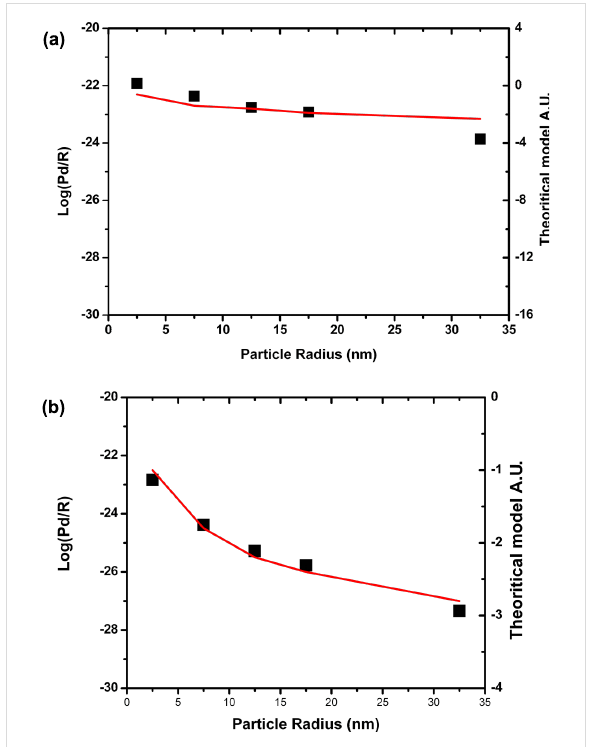
Figure 1: Evolution of the logarithm of the dissipated power normal- ized by the radius ( R ) as a function of (a) as-synthesized spherical Au nanoparticles on bare silicon wafer versus the particle radius R (squares: experimental data; solid line: theoretical data) corres- ponding to a pure sliding model and (b) spherical Au nanoparticles on silicon wafer coated with –CH 3 terminated groups (hydrophobic coating) versus the particle radius R (squares: experimental data, solid line: theoretical data) corresponding to a pure rotation model. Both after the tap of a tip in a typical AFM tapping mode manipulation as described by Sitti [37,38].